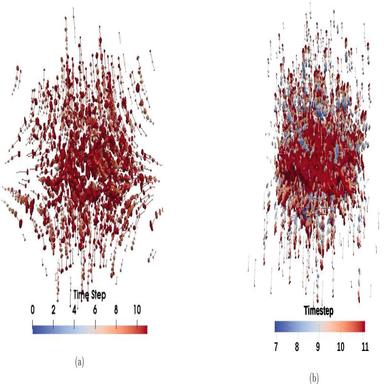
Tracking of voids in both (a) notched and (b) smooth iron sample.